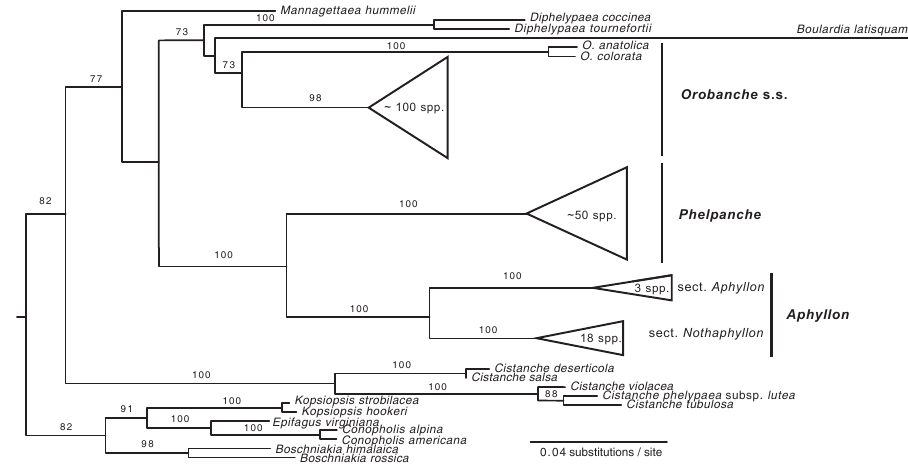
Figure 1. Maximum likelihood (ML) phylogram of Aphyllon and related holoparasite species inferred from 3 nuclear DNA loci (ITS, phytochrome A and phytochrome B). Bootstrap support values >70% are labeled. Due to space constraints, several clades have been collapsed. For a more detailed and thorough study of phylogenetic relationships within Aphyllon , see Schneider et al.